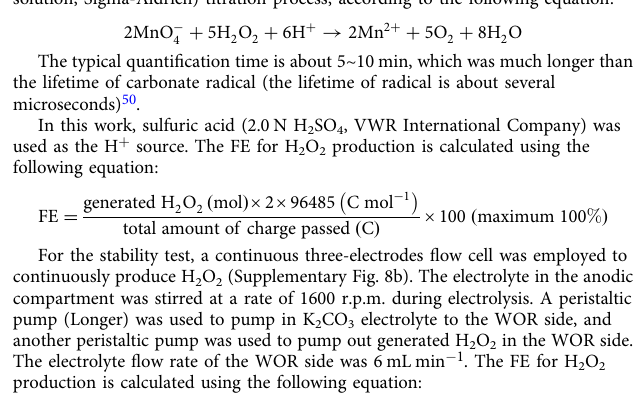
(Apiezon wax WW100) during electrochemical tests. Before electrochemical measurements, all samples were pre-stabilized at 20mAcm − 2 to clean the FTO surface. All potentials measured against SCE (E SCE ) were converted to the RHE (E RHE ) scale in this work using E RHE = E SCE + 0.244 V + 0.0591 × pH, where pH values of the electrolytes were determined by an Orion 320 PerpHecT LogR Meter (Thermo Scienti fi c). The pH values of investigated electrolytes are listed in Sup- plementary Table 2. The electrolyte in the anodic compartment was stirred at a rate of 1,600 r.p.m. during electrolysis. All the measured potentials were manually compensated unless stated otherwise. The overall resistance was determined by potentiostatic electrochemical impedance spectroscopy at frequencies ranging from 0.1Hz to 200 kHz, and manually compensated as E (iR corrected versus RHE, where iR is the voltage drop from overall resistance) = E (versus RHE) – R (the overall resistance, including the electrolyte resistance and the intrinsic resistance of the electrode) × i (amps of average current). The impedance number was about 12 to 17 Ω . DC stabilized power supply (ITECH) was used for the ultra-high current density (over 1 Acm − 2 ) electrolysis. The volume of the electrolyte solution was 25mL, and the reaction time was determined by the electrolysis current to insured the total electrolysis coulomb was about 10 to 50C. After electrolysis, the generated H 2 O 2 was detected by using the standard potassium permanganate (0.1 N KMnO 4